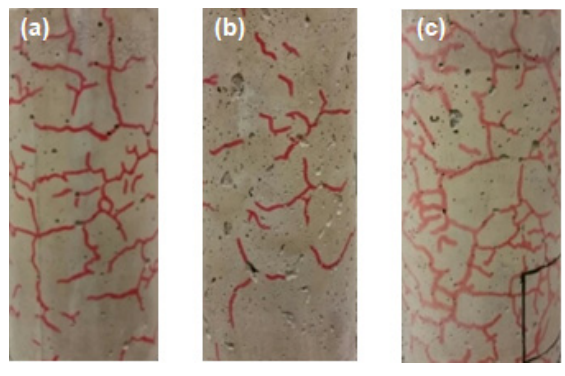
Figure 6. Distribution of cracks in the frontal view of concrete specimens: ( a ) CREF; ( b ) CPP3; ( c ) CPW3.